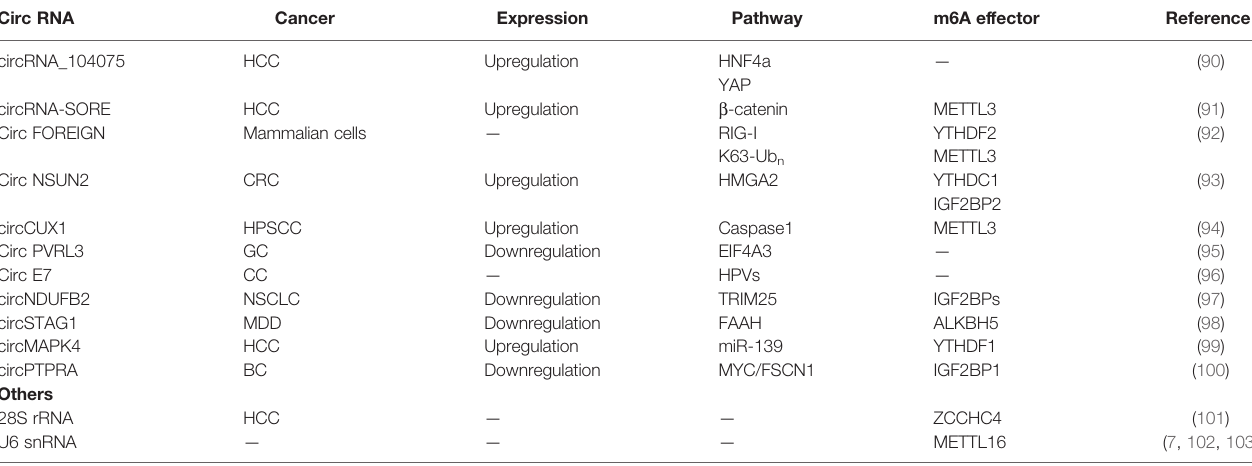
TABLE 3 | CircRNAs in cancer or normal cells and related m6A effectors. Circ